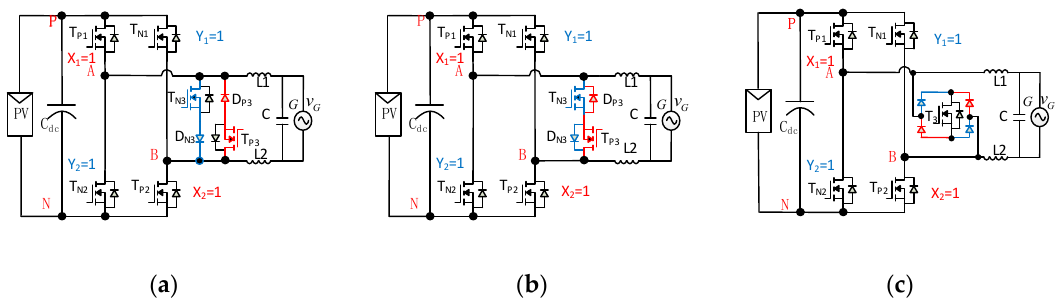
Figure 9. Three topologies under X 1 = 1, X 2 = 1, Y 1 = 1, and Y 2 = 1. ( a ) R1 [13]; ( b ) R2 [13]; ( c ) R3 [30]. Table 1. Topological families under M = 2 and N = 2. Family with Extra Diode Family without Extra Diode